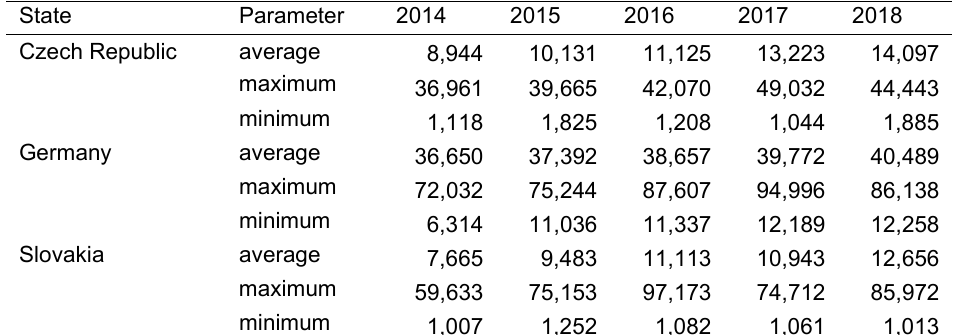
Table 1. Remuneration of a road freight transport employee in euros for the years 2014 to